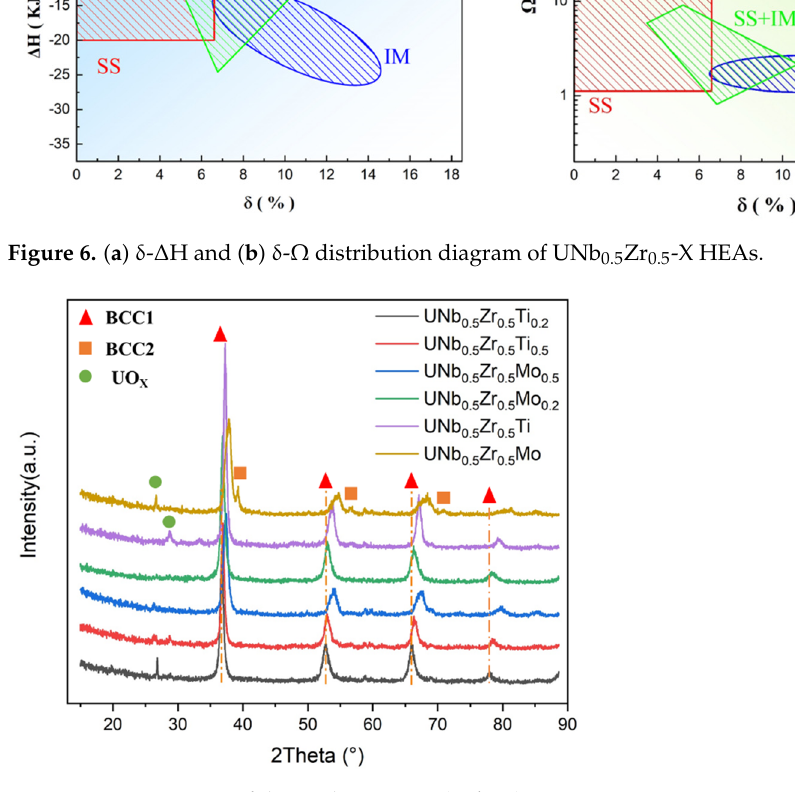
Figure 7. XRD pattern of the UNb 0.5 Zr 0.5 -X (Ti/Mo) HEAs. The as-cast microstructures of UNb 0.5 Zr 0.5 -X (Ti/Mo) HEAs are shown in Figure 8, and the alloys all have a typical as-cast dendritic structure similar to the U-Nb-Zr system alloys. Com- position segregation was obvious as the concentration of Ti and Mo increased. UNb 0.5 Zr 0.5 Ti 0.2 , UNb 0.5 Zr 0.5 Ti 0.5 , UNb 0.5 Zr 0.5 Ti, UNb 0.5 Zr 0.5 Mo 0.2 , and UNb 0.5 Zr 0.5 Mo 0.5 consisted of a uni- form region, a U-enriched region and a UO x region. Compared with UNb 0.5 Zr 0.5 Ti 0.2 and UNb 0.5 Zr 0.5 Ti 0.5 , the segregation of the U-enriched region in UNb 0.5 Zr 0.5 Ti was high obvi- ously. UNb 0.5 Zr 0.5 Mo was composed of a U-enriched region, Mo-enriched region, and UO x , which was different from UNb 0.5 Zr 0.5 Mo 0.2 and UNb 0.5 Zr 0.5 Mo 0.5 . As Figure 8f shows, the Mo-enriched region formed the BCC2 phase that is in line with the XRD patterns of Figure 7. Table 7 shows the Brinell hardness and yield strength of the UNb 0.5 Zr 0.5 -X HEAs. The addition of Ti significantly reduced the hardness of the alloy. When the molar ratio of Ti was 0.5, the yield strength of the alloy reached 881 MPa. While the hardness of the alloy improved dramatically as the Mo percentage increased, the yield strength decreased. This was because the hardness of Mo was higher than that of other elements. In addition, the melting point of Mo was the highest of the five elements, which will improve segregation during the solidification process. As a result, the hardness increased dramatically, and segregation of the alloy increased along with the Mo content, dramatically influencing the mechanical characteristics of the